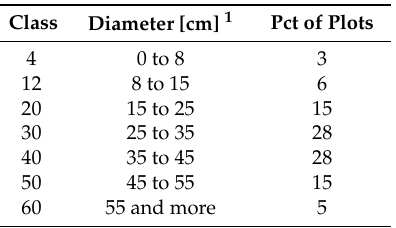
Table 3. Classification levels of the average diameter used for stratification with pct of plots in the BSFI (Bavarian State Forest Inventory) data (see Section